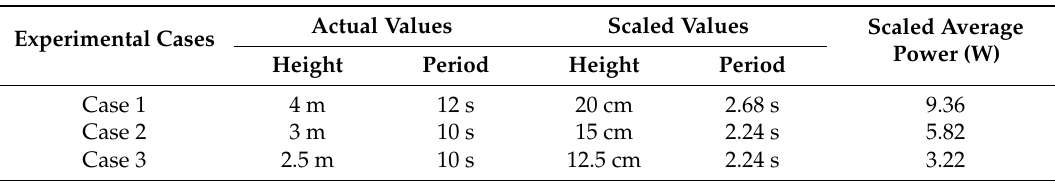
Table 1. Three cases for the experiment.